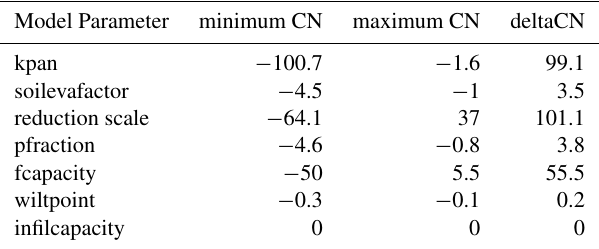
Table 3. Comparison of the model sensitivity to selected parame- ters.